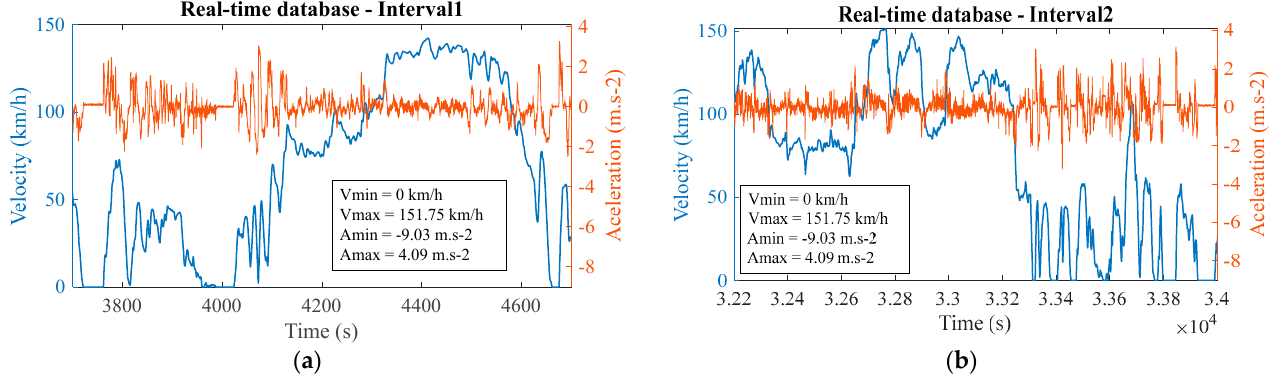
Figure 8. Two interesting intervals extracted from the 27-h real-time measured database ( a ) Interval1; ( b ) Interval2.